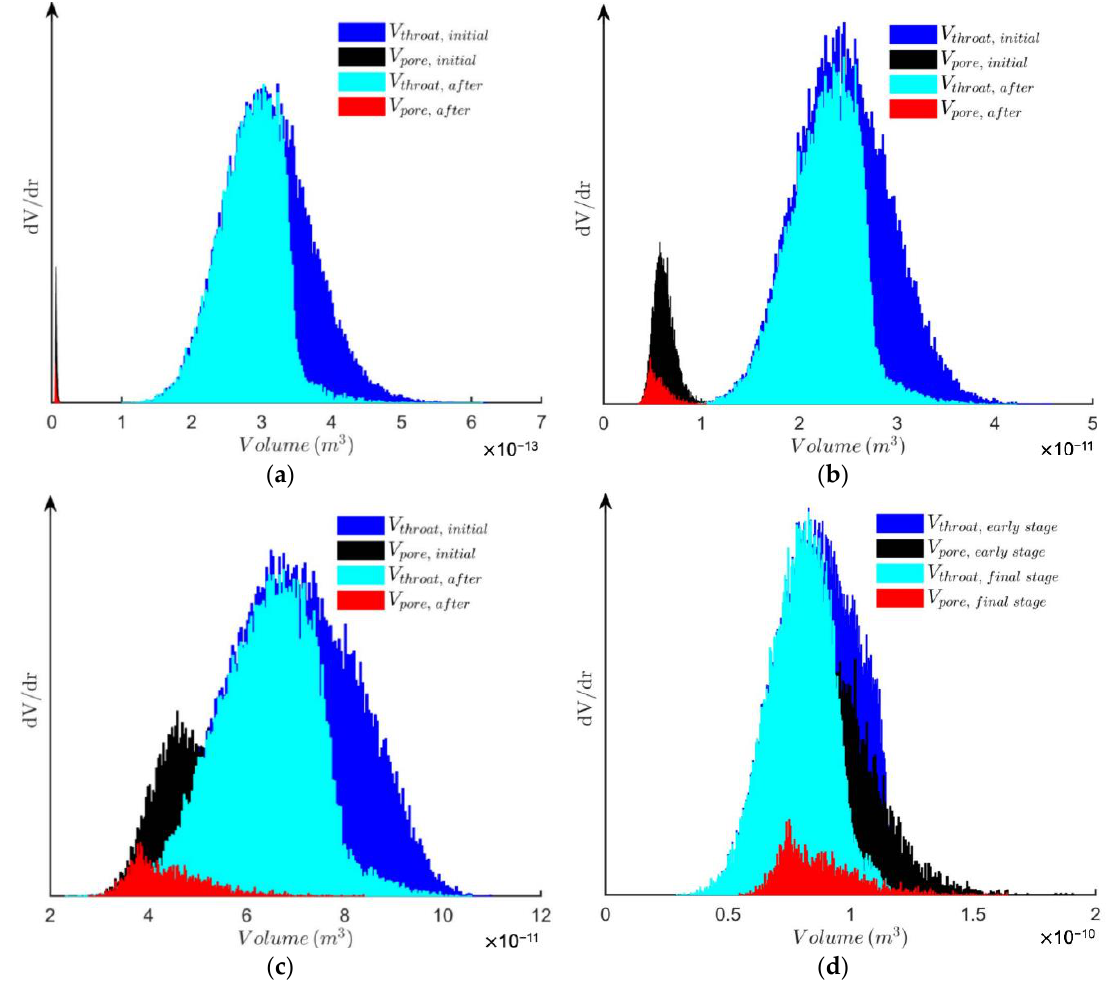
Figure 4. The volume distribution of liquid-filled throats and pores in the network at the beginning of the capillarity-controlled IP process and at 𝑆 𝑟 for a single simulation: ( a ) 𝜎 0 /𝑟 ̅ = 1/10 (µm), 𝑟̅ 𝑝 𝐿̅ 𝑡 ⁄ = 0.01 ( b ) 𝜎 0 /𝑟 ̅ = 10/100 (µm), 𝑟̅ 𝑝 𝐿̅ 𝑡 ⁄ = 0.15 ( c ) 𝜎 0 /𝑟 ̅ = 20/200 (µm), 𝑟̅ 𝑝 𝐿̅ 𝑡 ⁄ = 0.42 and ( d ) 𝜎 0 /𝑟 ̅ = 25/250 (µm), 𝑟̅ 𝑝 𝐿̅ 𝑡 ⁄ = 0.66 . The network connectivity is 6.